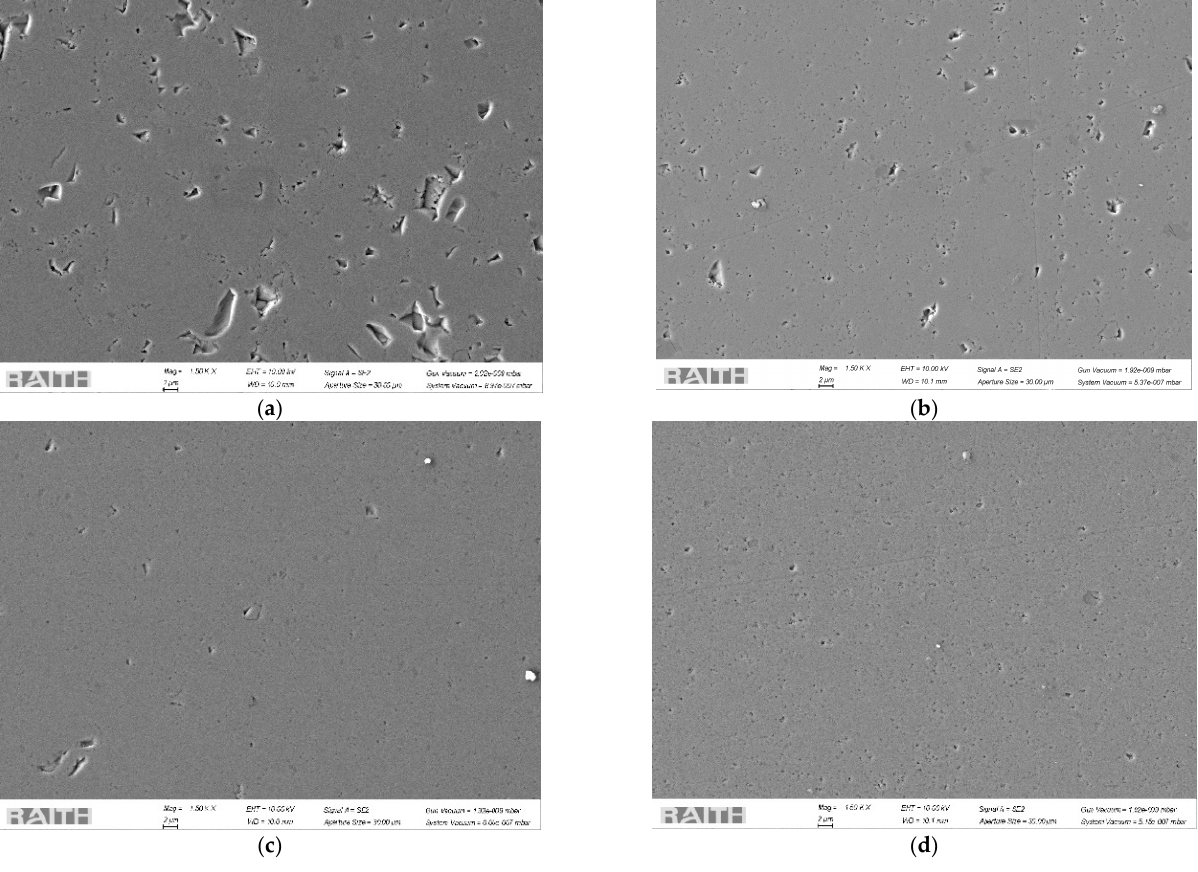
Figure 3. SEM images of sintered specimens: ( a ) HP1, ( b ) HP2, ( c ) HP3, and ( d ) HP4.